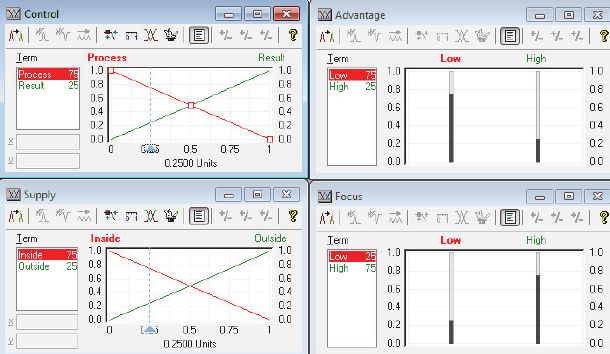
Fig. 6. Reviewing the results of alignment strategies in the relative control of the process and the inside relative supply